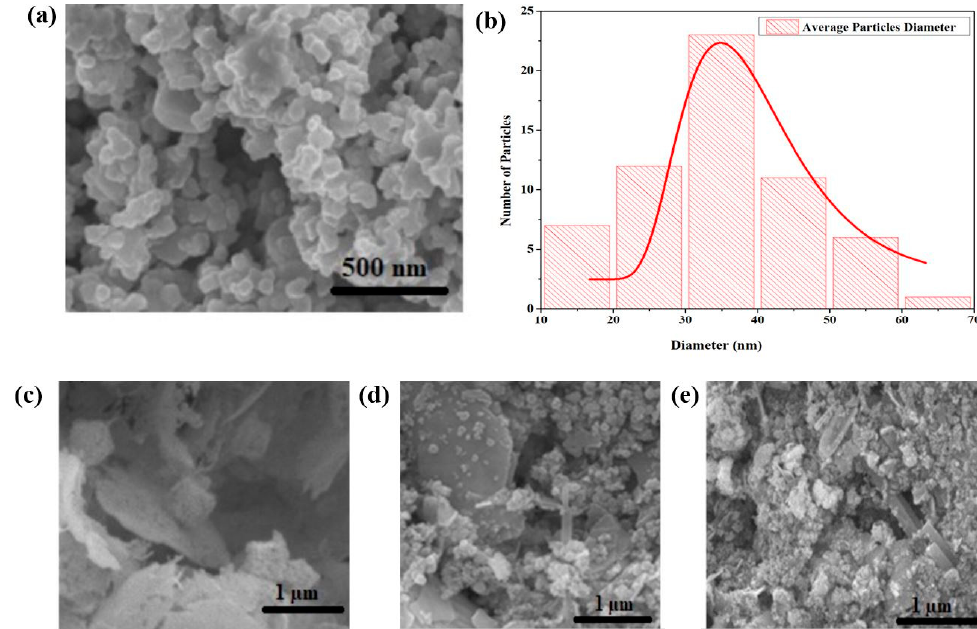
Figure 2. Surface morphology analysis by SEM: ( a ) green synthesized CeO 2 NPs, ( b ) PSD analysis of CeO 2 nanoparticles, ( c ) chitosan hydrogel membrane, ( d ) chitosan-loaded 1% CeO 2 NPs; ( e ) chitosan-loaded 5% CeO 2 NPs.